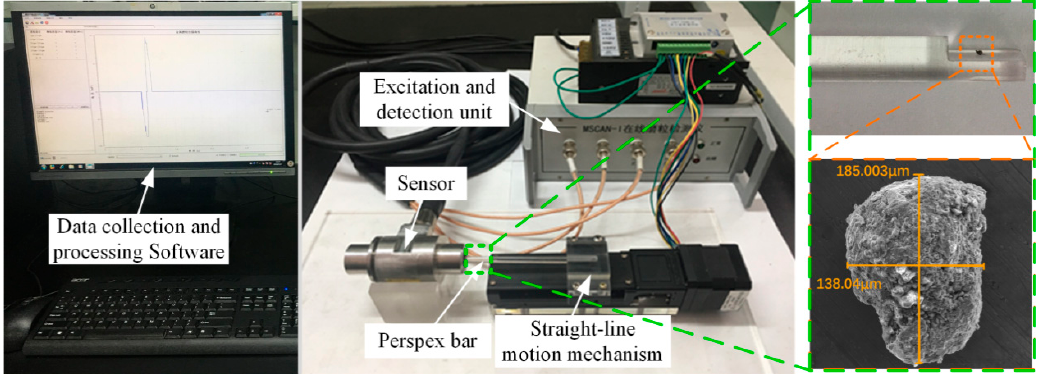
Figure 13. The experiment system. Table 2. The detailed parameters of the experiment system.